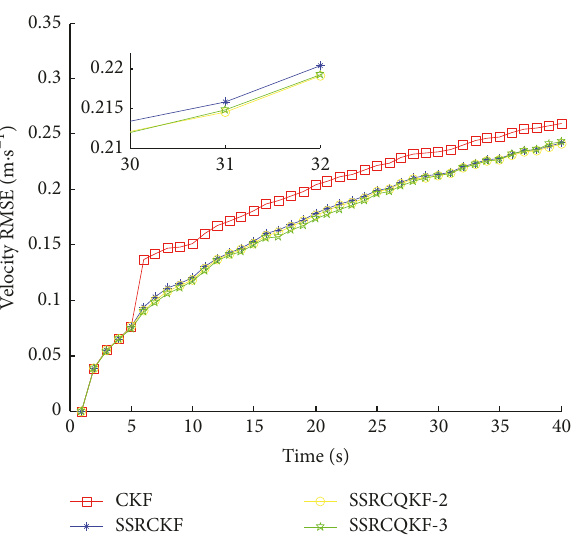
Figure 5: The velocity RMSE of various filters.